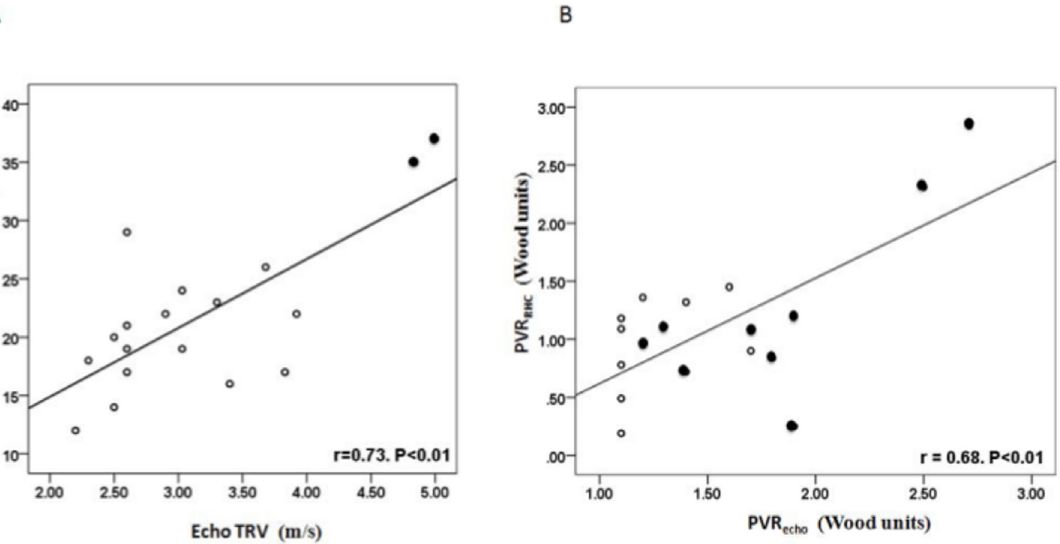
Fig 2. Correlation between echocardiographic estimates and invasive values of pulmonary haemodynamic parameters. A) TRV versus mean PAP; B) PVR echo versus PVR RHC . In A, solid symbols denote patients with PVR echo (cid:1) 2 Wood units. In B, solid symbols denote patients with TRV (cid:1) 3 m/s.